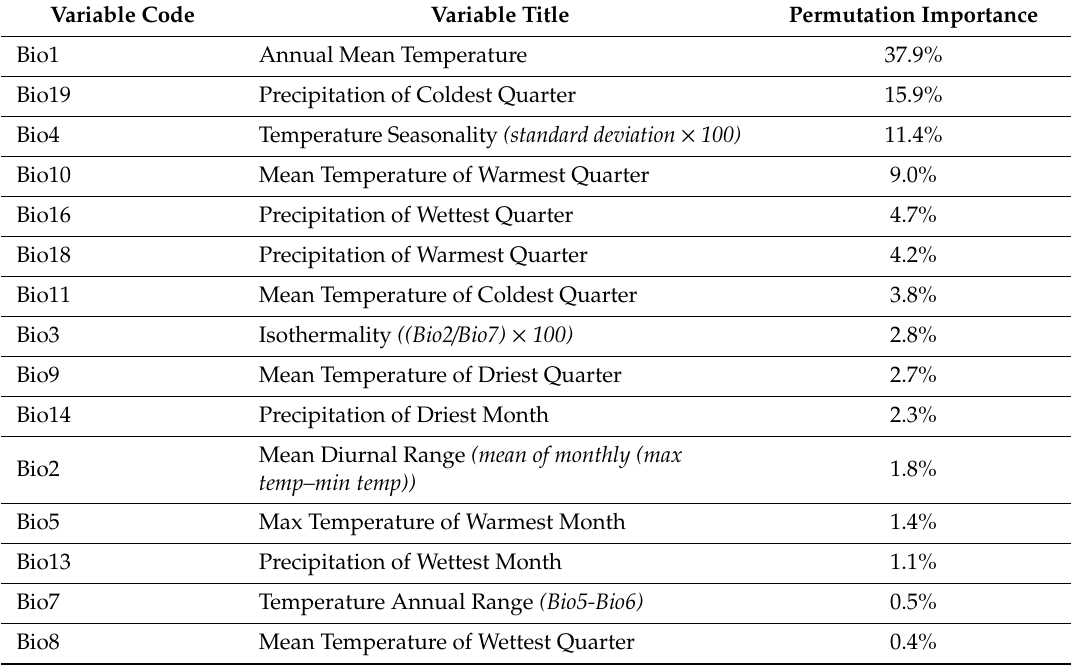
Table 2. The 15 variables used in the MAXENT method, listed in order of permutation importance. Variable permutation importance is a value showing how heavily the final model depends on a certain variable. Values of each variable in training, testing and background data are randomized and the resulting model is evaluated. The degree to which the randomly permuted data weakens the model’s performance, as originally selected by MAXENT, is normalised to a percentage for each variable and presented as permutation importance [34]. A variable with a high permutation importance is therefore important to the model, since if its values were randomized, the power of the model would decrease